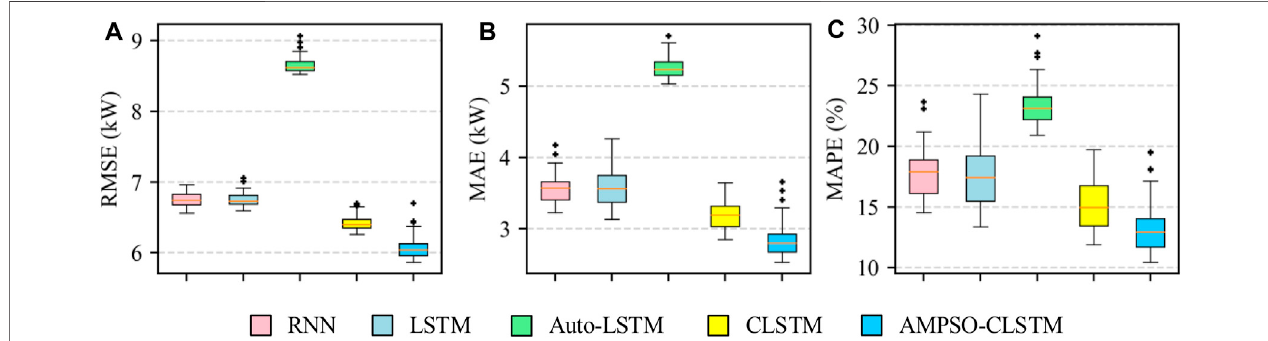
FIGURE 8 | Boxplots of error indexes for 50 independent runs on the Taiyangshan data set. (A-C) respectively show the RMSE, MAE and MAPE of all models in case 2.